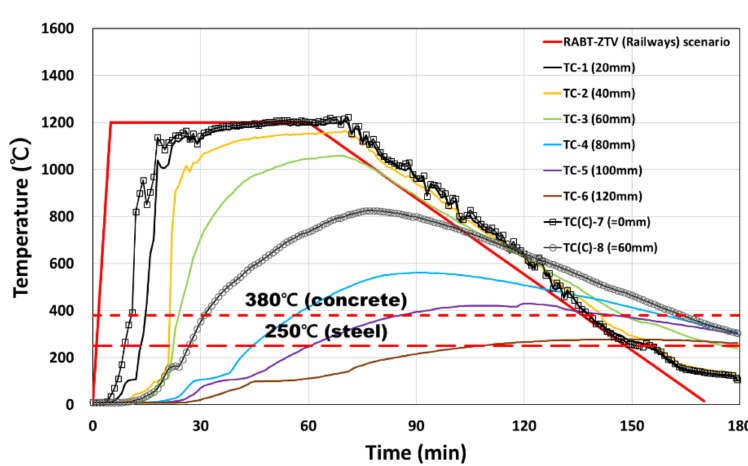
Figure 11. Temperature measurement results for the RABT-ZTV (highways) fire experiment.